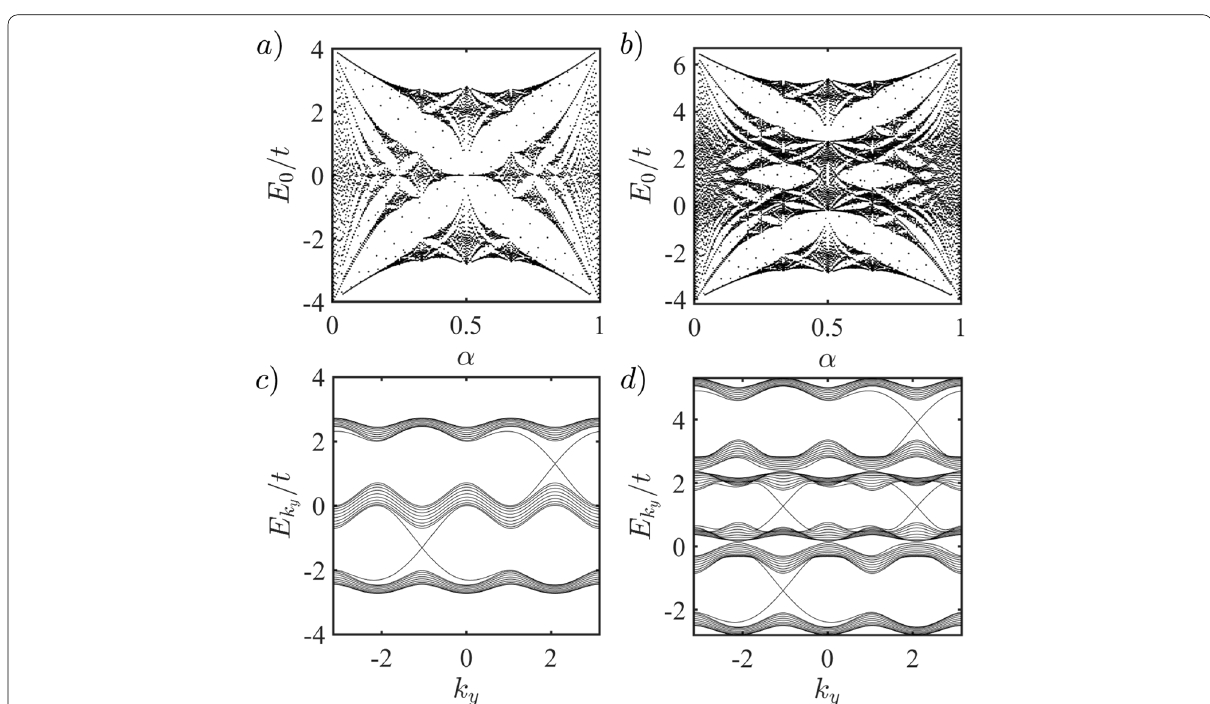
(in units of t ) of the Harper’s matrix Eq. (17) y